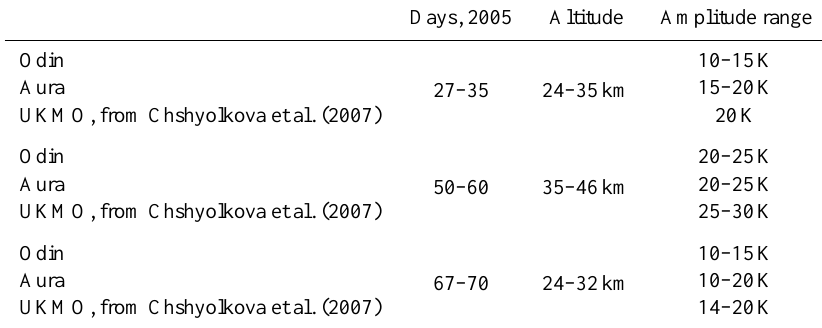
Table 2. Wavenumber one amplitude in temperature at 60 ◦